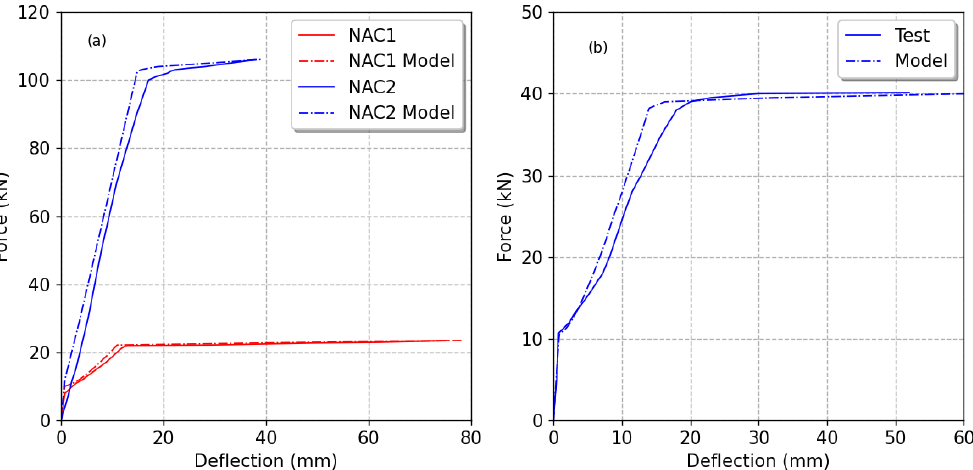
Figure 6. P-Δ diagram comparison: Experiments vs. Present Work; ( a ) Ignjatovic et al. [19]; ( b ) Seara-